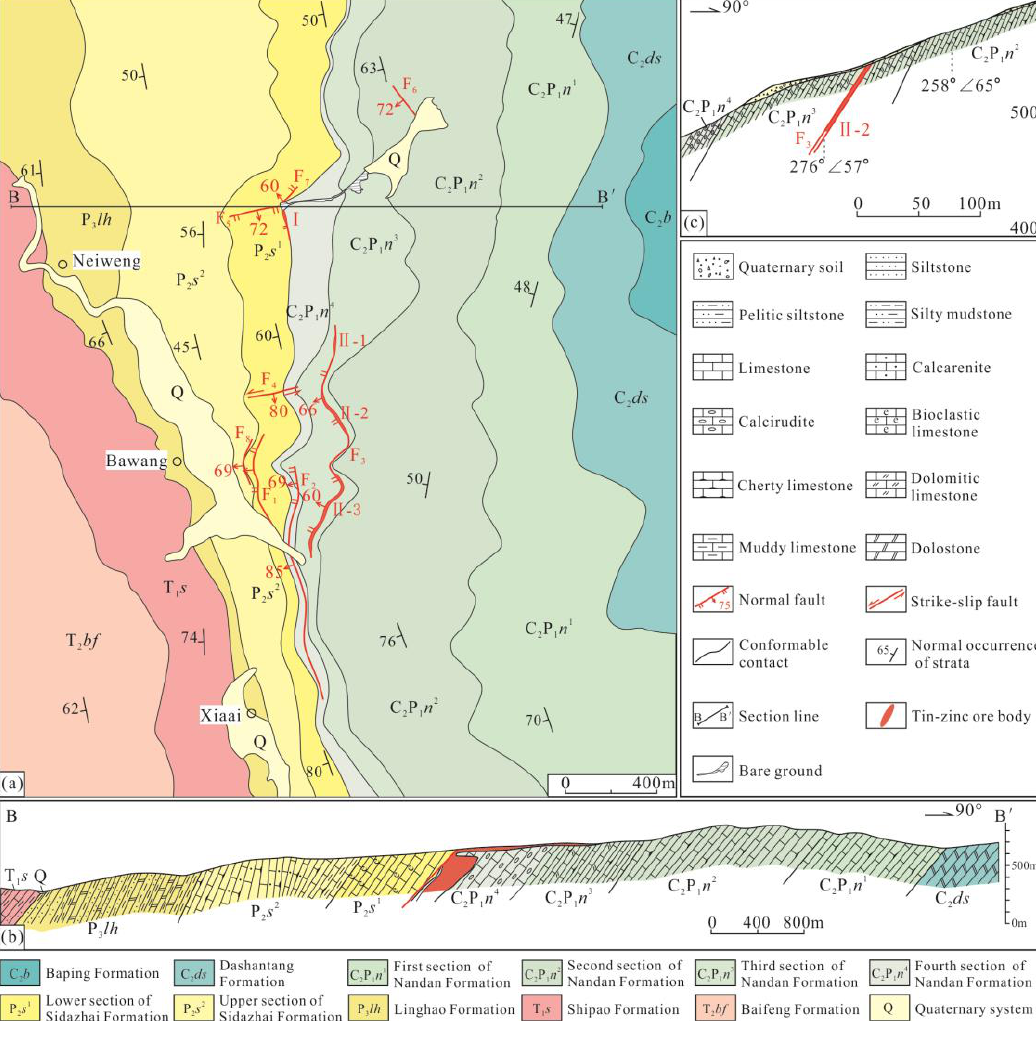
Figure 2. Geological sketch map ( a ) and ore-controlling structural styles ( b , c ) of the Bawang